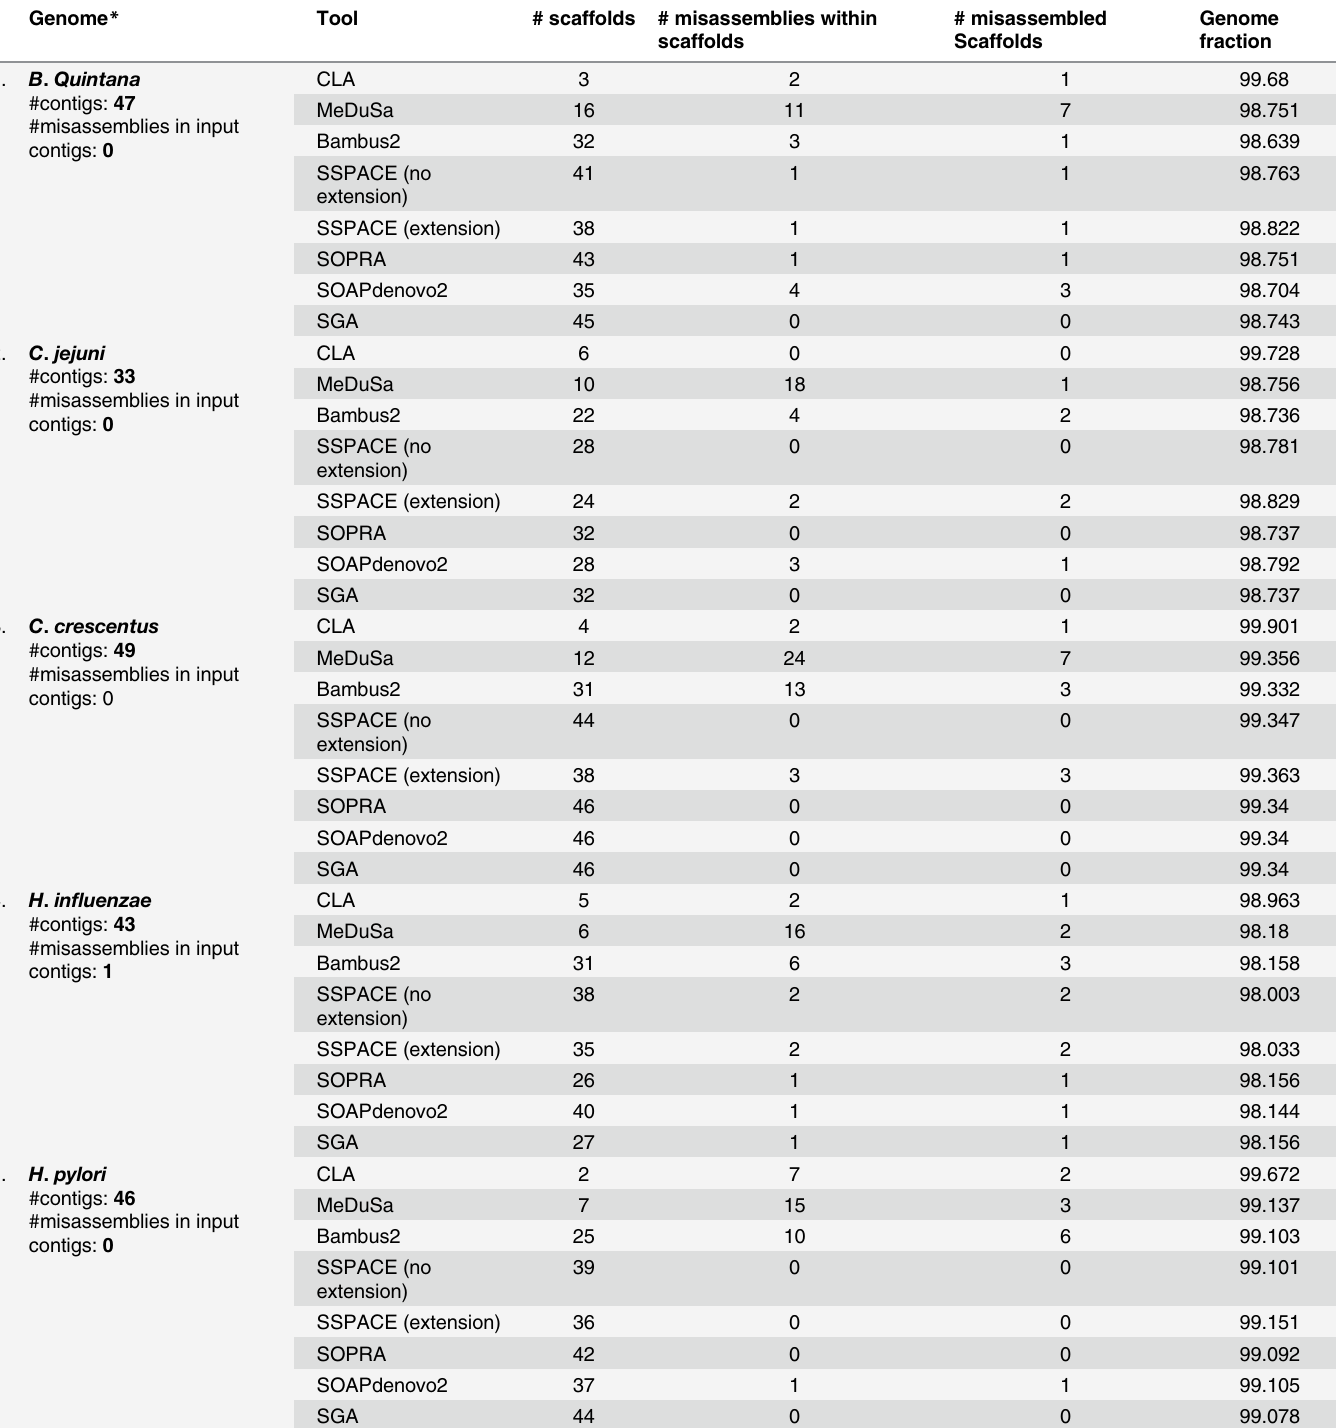
Table 3. Comparative statistics of CLA and Scaffolding tools generated using simulated dataset. Genome